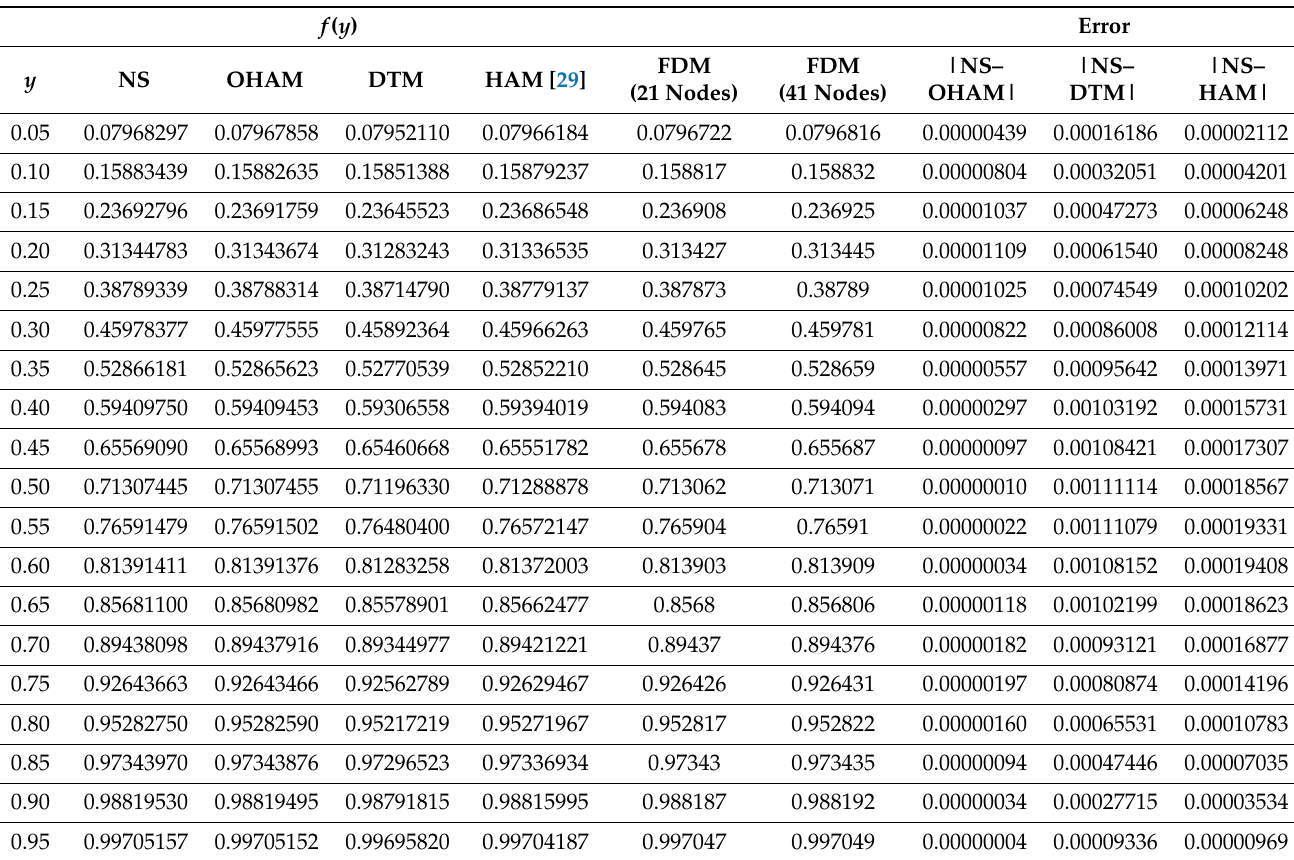
Table 2. Comparison of the numerical solution (NS) with the OHAM and HAM by 4th-order approximate solution and DTM ( m = 20) for the case of Re = 5 and α = 1.